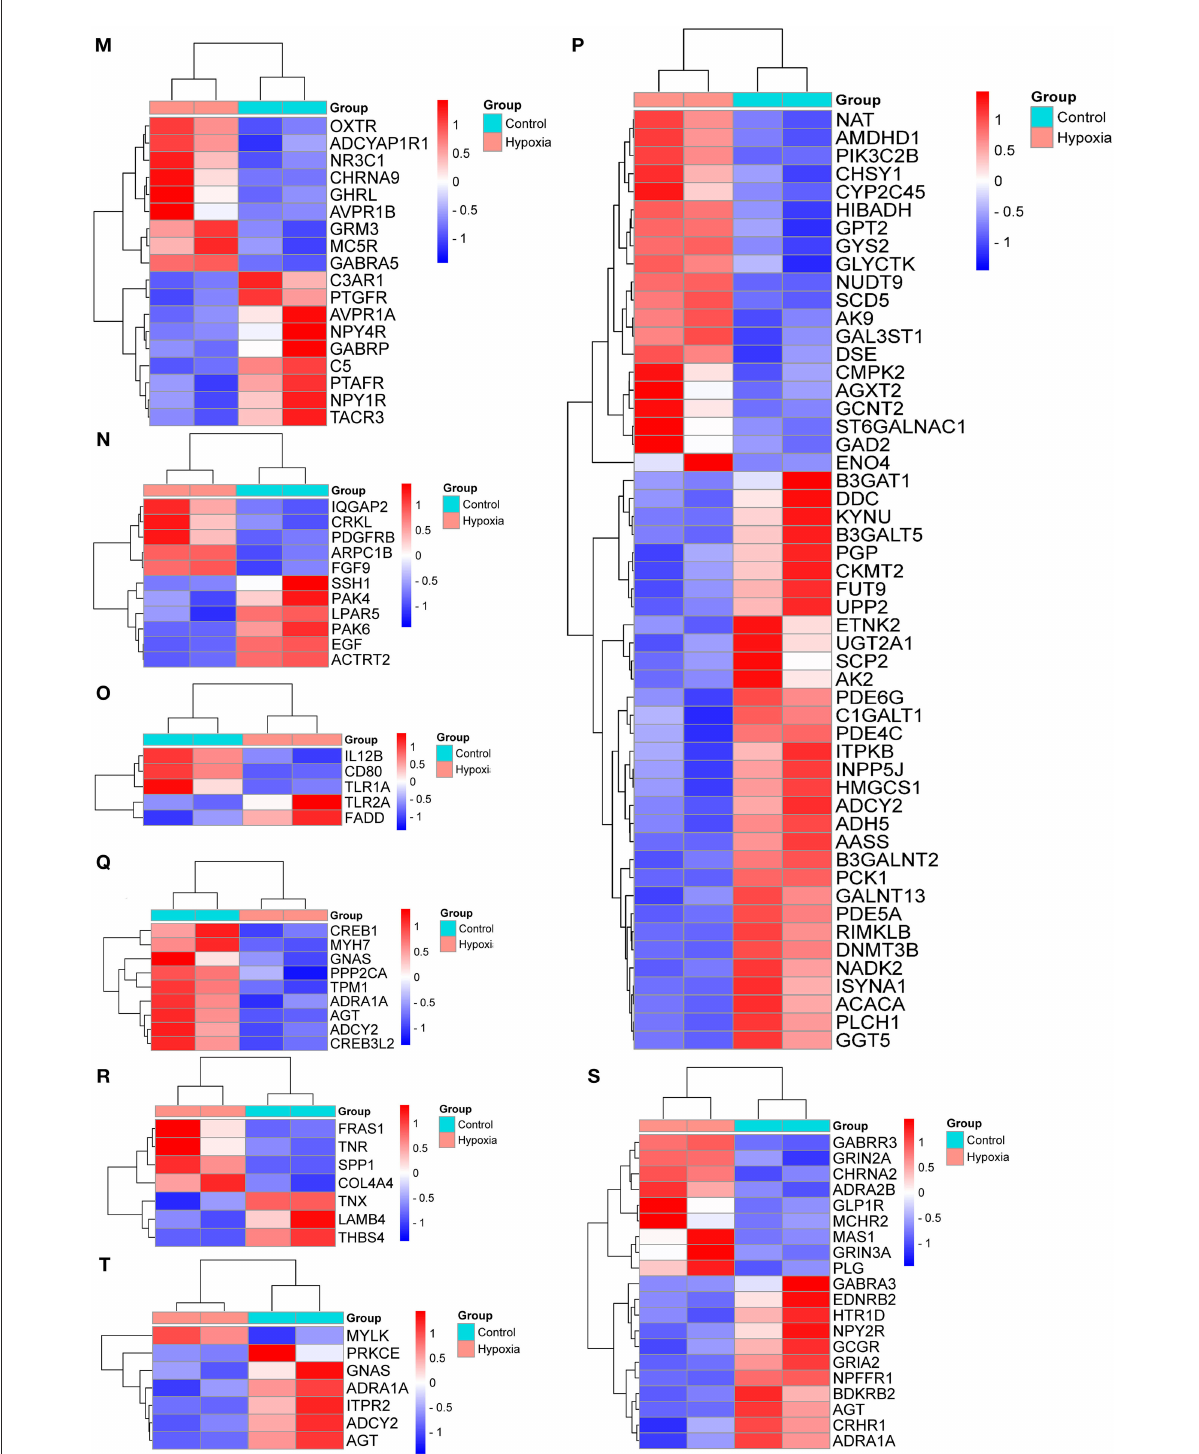
FIGURE3 KEGG analysis for the breed-special DEGs. (A–C) indicated the KEGG analysis for the breed-special DEGs in the hearts of SG, TB, and DRW chickens treated with hypoxia and normoxia. (D–H) showed the heatmaps of the breed-special DEGs in metabolic pathways, MAPK, NLRI, NOD-like receptor, and toll-like receptor signaling pathways in SG chickens. (I–O) revealed the heatmaps of the breed-special DEGs in metabolic pathways; calcium, insulin, MAPK; NLRI; regulation of actin cytoskeleton; and toll-like receptor signaling pathways in TB chicken. (P–T) showed the heatmaps of the breed-special DEGs in metabolic pathways; adrenergic signaling in cardiomyocytes, ERI, NLRI, and vascular smooth muscle contraction signaling pathways in DRW